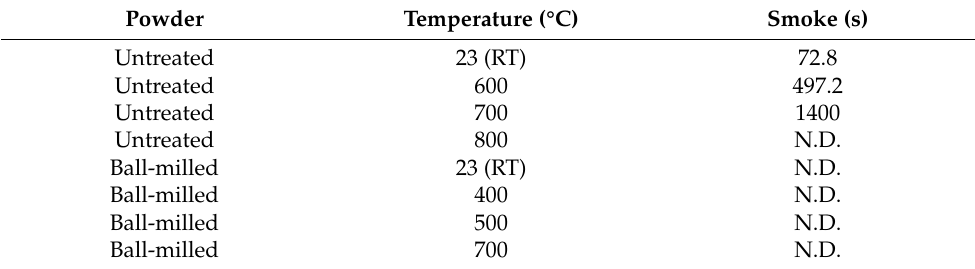
Table 5. Summary of the results of the smoke detection tests for the virgin and ball-milled (30